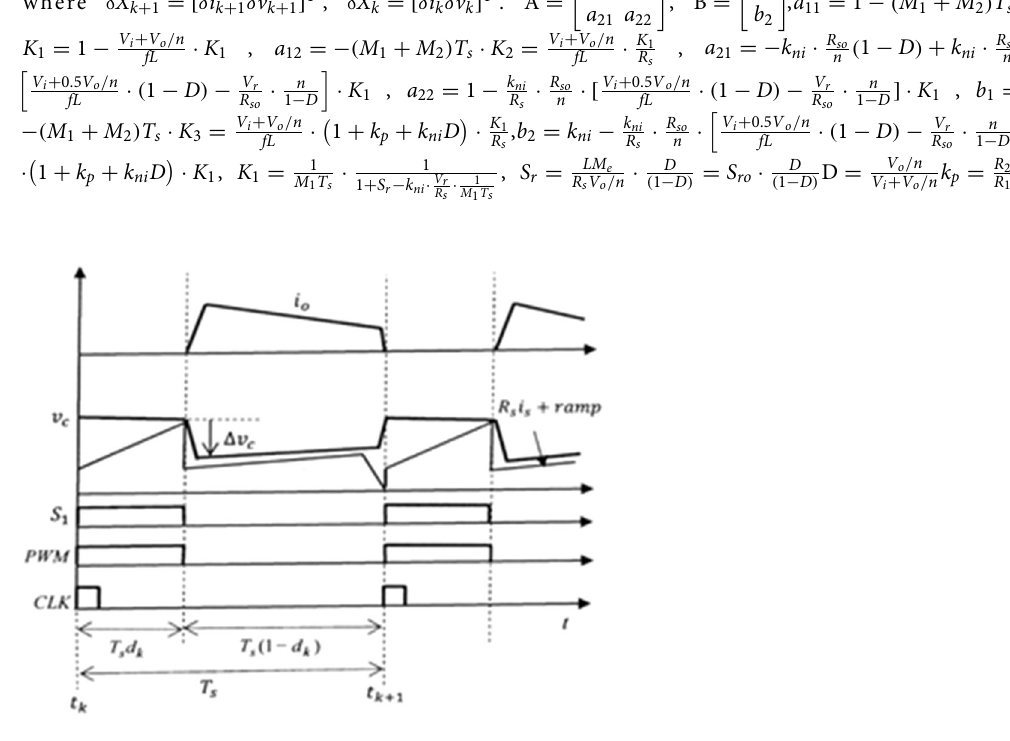
Figure 4. Effect of k p on the control signal v c : (cid:31) v c = k p R so i o